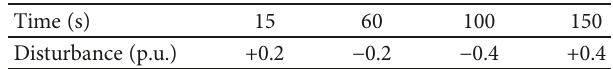
Table 2: The disturbance from load